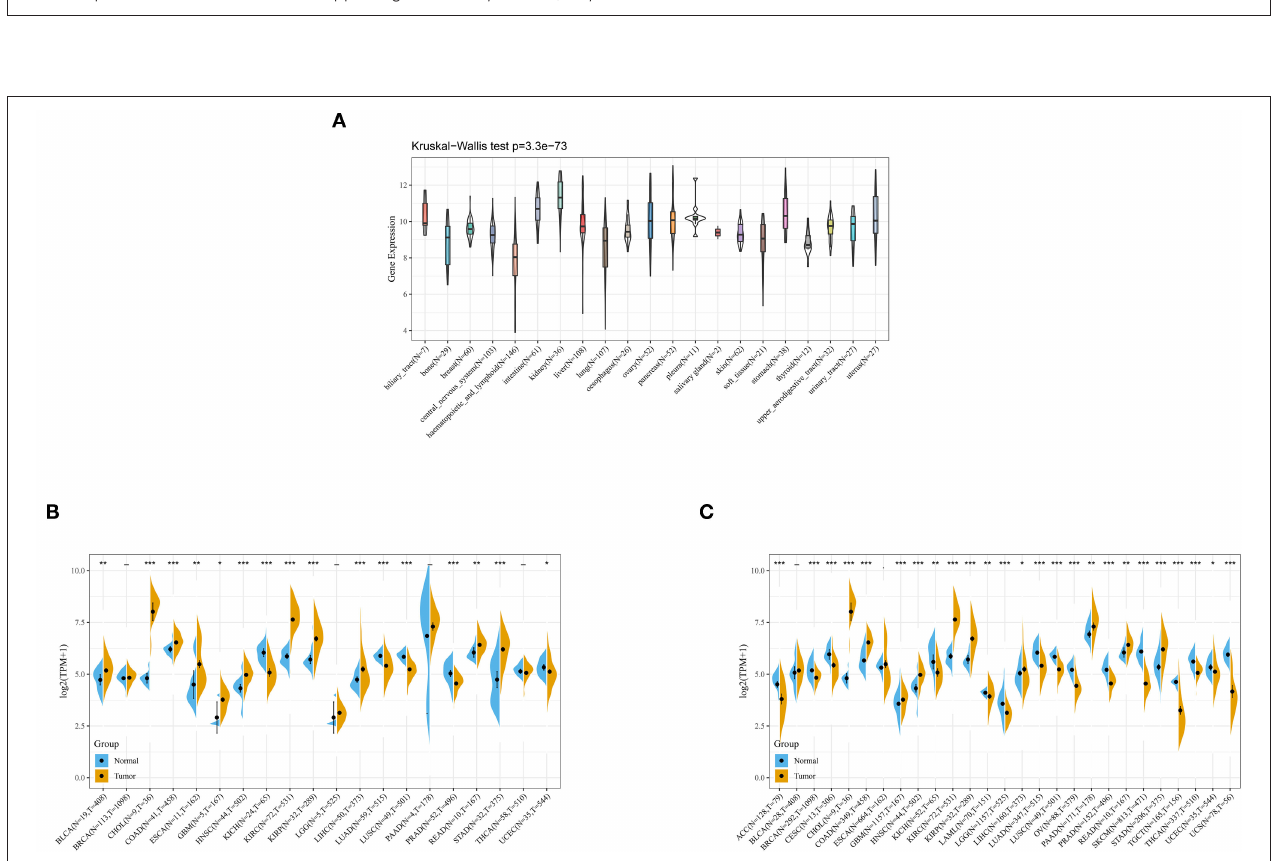
FIGURE 4 | ANXA4 expression in different cancer types. (A) Expression levels of ANXA4 in different cancer cell lines. (B) Expression levels of ANXA4 in TCGA. (C) Expression levels of ANXA4 in combination with the GTEx database and TCGA. * p < 0.05, ** p < 0.01, *** p < 0.001.